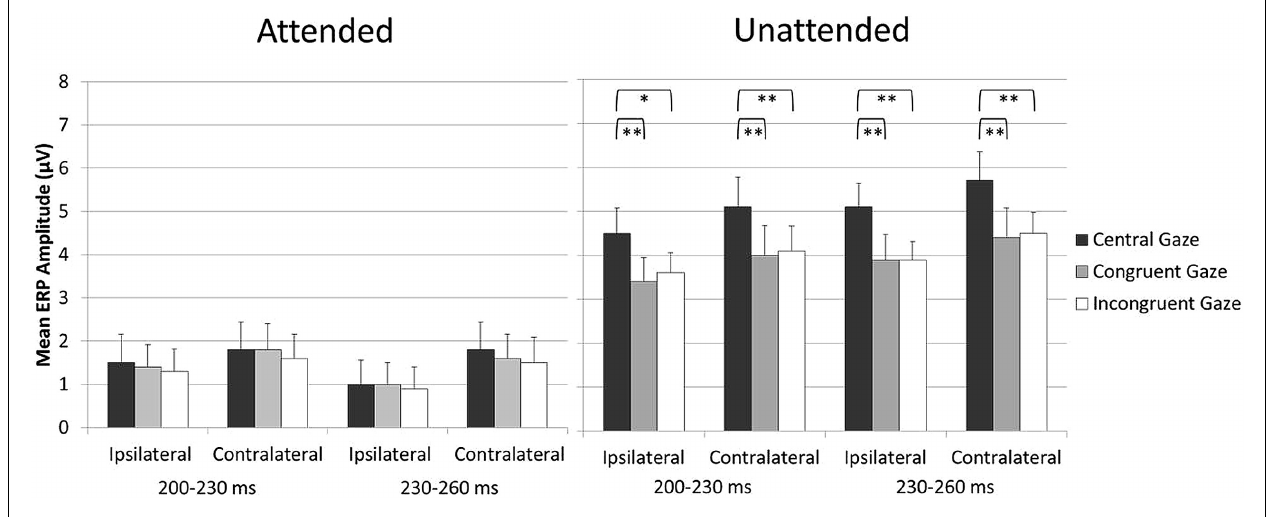
FIGURE 4 | Mean ERP amplitude elicited by attended stimuli (left panel) and unattended stimuli (right panel) over central electrodes ipsilateral and contralateral to the stimulated hand in the 200- to 260-ms time interval after stimulus onset, shown